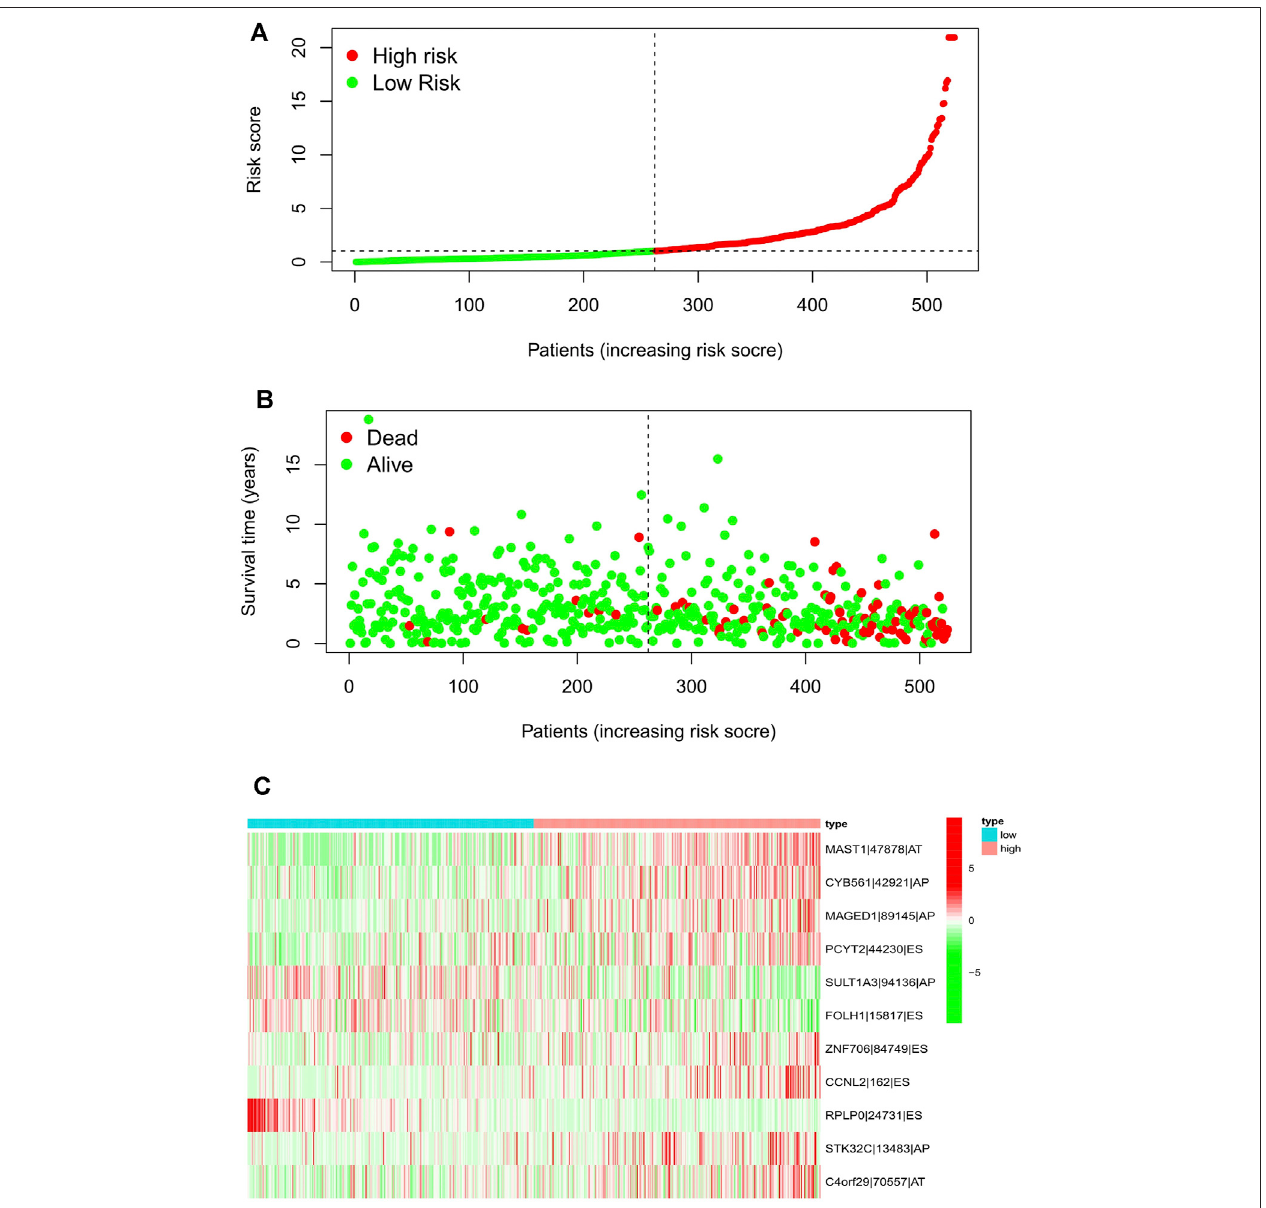
FIGURE2| Riskscoredistributionofthe11-ASeventssignatureintheTCGAcohort.Riskscores (A) ,survivalstatus (B) ,andheatmap (C) ofthe11-ASeventsPSI pro fi les were shown from top to bottom. AA, alternate acceptor; AD, alternate donor; AP, alternate promoter; AT, alternate terminator; ES, exon skip; ME, mutually- exclusive exons; RI, retained